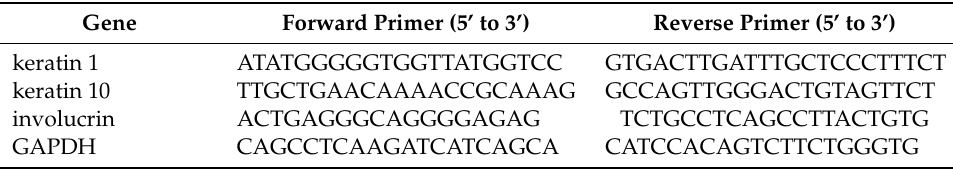
Table 2. The list of primers used for RT-qPCR.